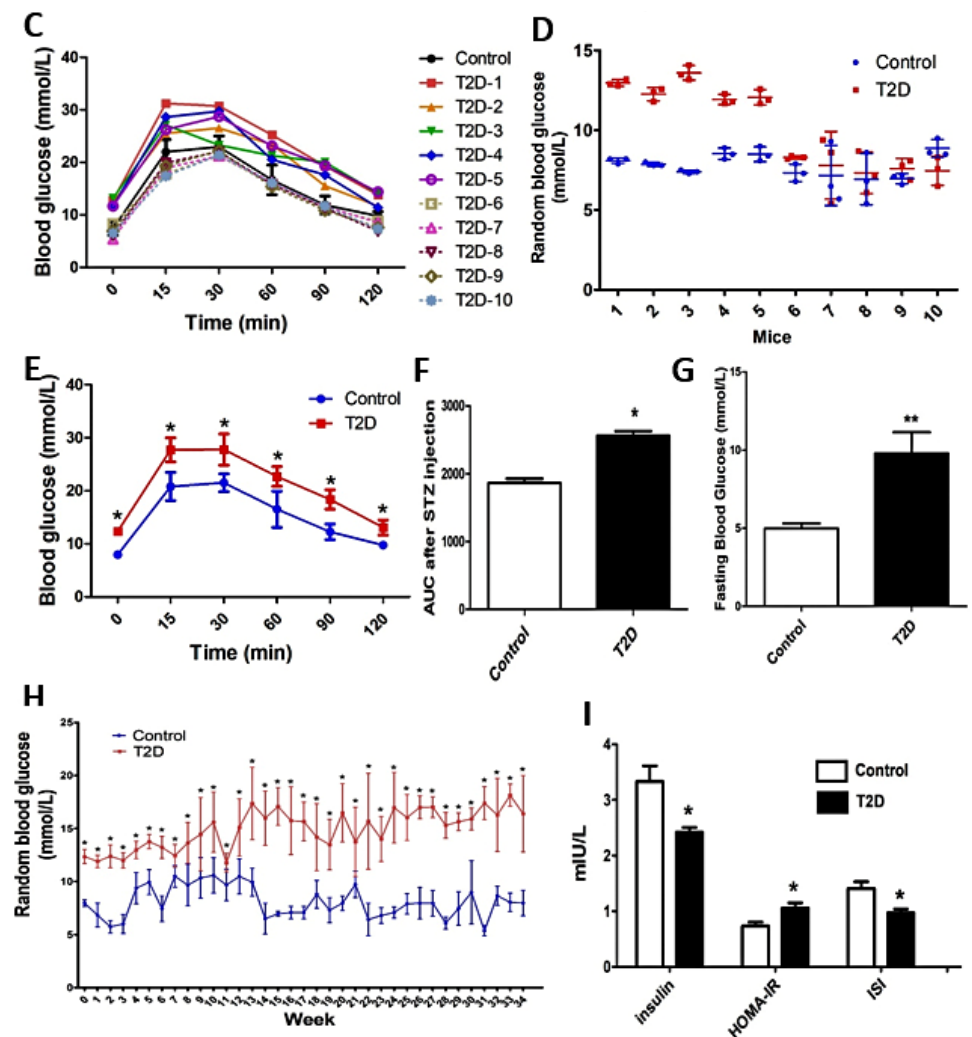
Figure 1. The induction of type 2 diabetes (T2D) and blood glucose changes in ApoE-/- mice. ( A ) An intraperitoneal glucose tolerance test (IPGTT) was performed on mice of each group ( n = 10) before the injection of streptozocin (STZ) or vehicle, and ( B ) the area under the curve (AUC) was correspondingly calculated. ( C ) IPGTT was performed again on mice of each group ( n = 10) after STZ injection. The IPGTT curve was plotted using the average blood glucose value of all mice in the control group ( n = 10), but using the individual blood glucose value of each mouse in the T2D group ( n = 10). ( D ) The random blood glucose levels of mice ( n = 10) in each group were determined once a day for three consecutive days after STZ injection. The ( E ) IPGTT curve and ( F ) AUC value of mice in the final control ( n = 5) and T2D ( n = 5) group were presented after STZ injection. ( G ) The fasting blood glucose (FBG) of mice ( n = 5) in each group was determined at the end of the experiment. ( H ) The random blood glucose ( n = 5) was detected once a week during the whole period of the experiment. ( I ) The serum insulin levels of mice ( n = 5) were determined using ELISA kits at the end of the experiment and the homeostasis model assessment for insulin resistance (HOMA-IR) and insulin sensitivity index (ISI) were correspondingly calculated. Data were statistically analyzed using the independent sample t-test in the SPSS 20.0 software. Results represent means ± S.D. of the samples ( n = 10 or n = 5). *: p < 0.05 vs. control. **: p < 0.01 vs.